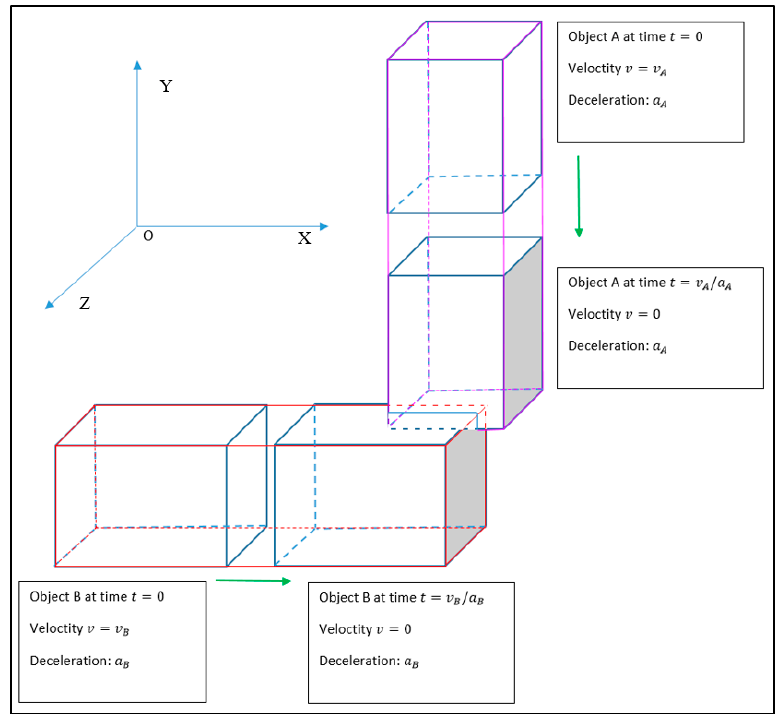
Figure 7. Axis-aligned anti-collision box of objects.